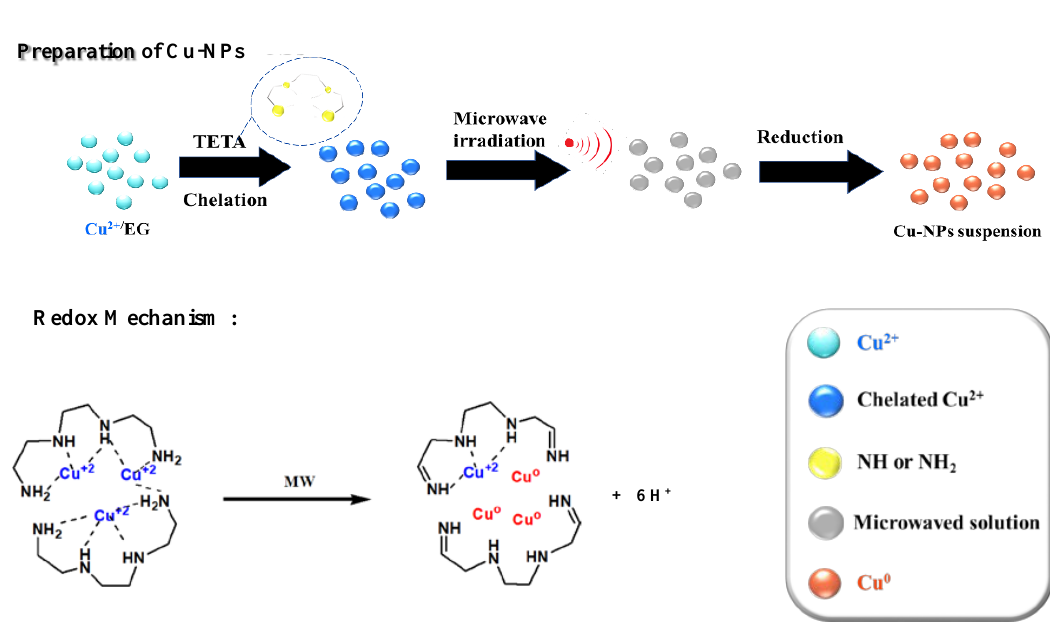
Scheme 1. Schematic diagram and reaction mechanism of preparation of Cu-NPs before and after microwave (MW) irradiation.